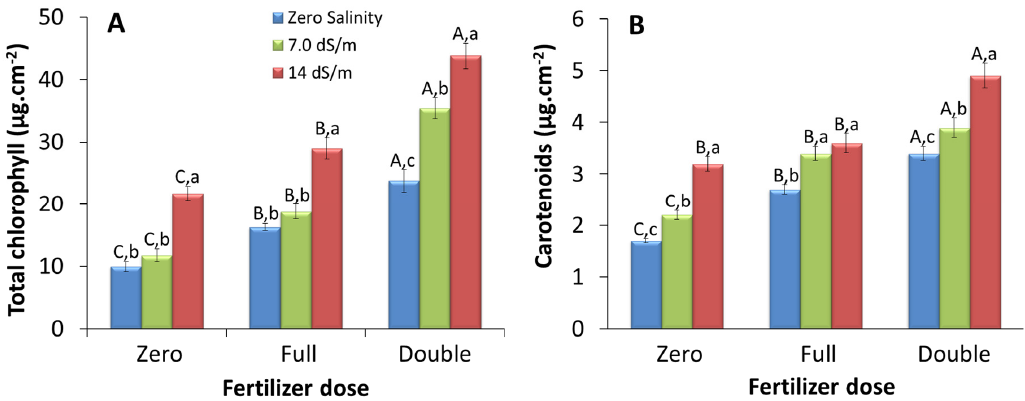
Figure 1. Pigment contents in wheat leaf under various treatments employed in the experiment expressed as µ g · cm − 2 : ( A ) total chlorophyll and ( B ) total carotenoids content. Fertilizer treatments are grouped along the x-axis, and different color bars represent treatment of salinity. ANOVA was performed to test the effect of salinity and fertilizer treatments and their interaction. The post-hoc analysis was performed using Tukey’s HSD test. Statistically significant differences are represented by different letters above the bars. Different capital letters indicate significant differences among the three fertilizer doses at a given salinity level (two-way ANOVA, Tukey’s test, p < 0.01). Different lowercase letters indicate significant differences among salinity treatments in each fertilizer dose (two-way ANOVA, Tukey’s test, p < 0.01). Means with same letters show non-significant difference at p < 0.01. Values are means of ~30 observations with error bars as standard deviations of the mean. Statistical analysis showed that the effect of fertilizer dose on Chl t was significant ( p < 0.01) at all salinity levels. On the other hand, the salinity levels showed a significant difference only at the